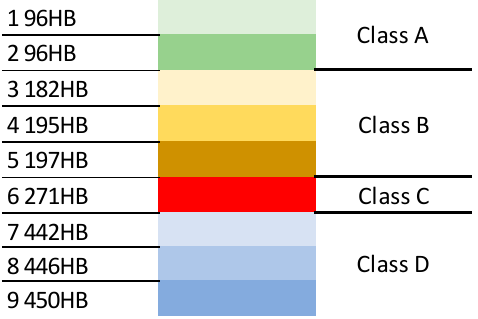
Figure 8. The original and the new classes with the colures assigned.